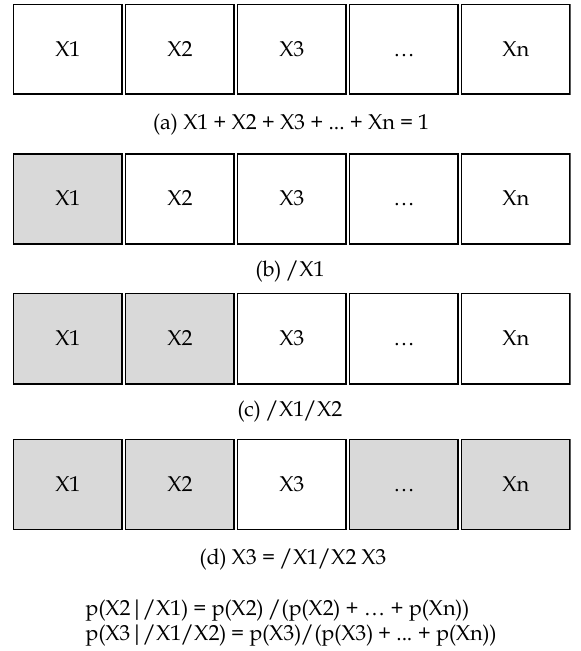
Figure 2. Venn diagram for partitioning events (no intersections).